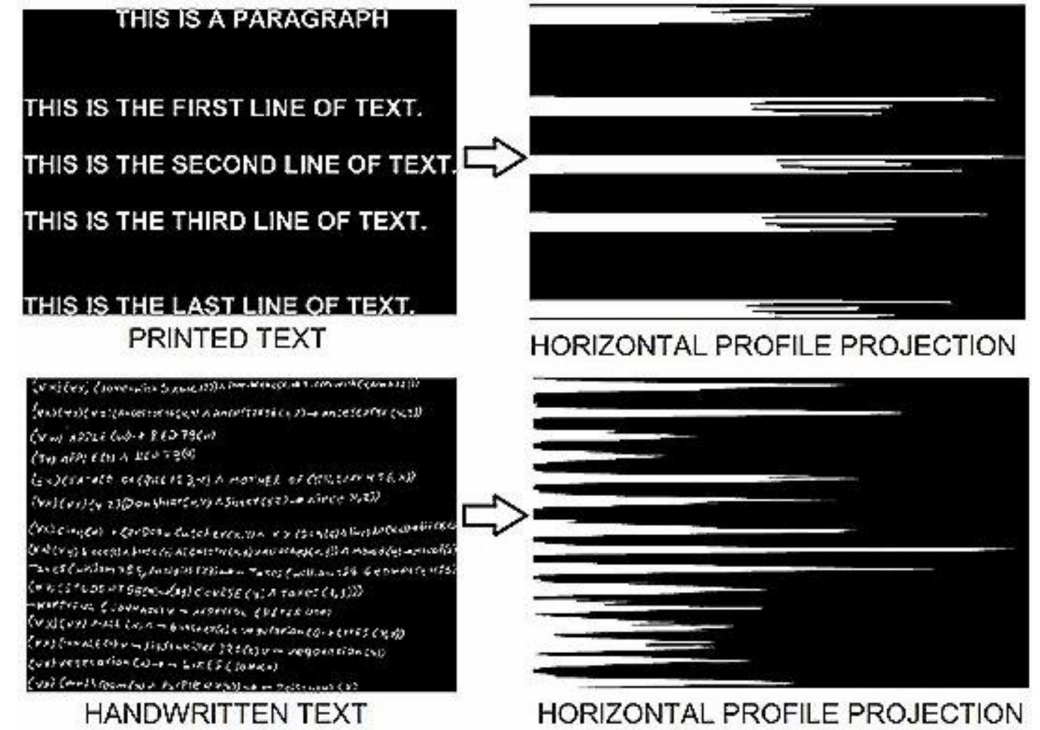
Figure 5. Horizontal profile projection